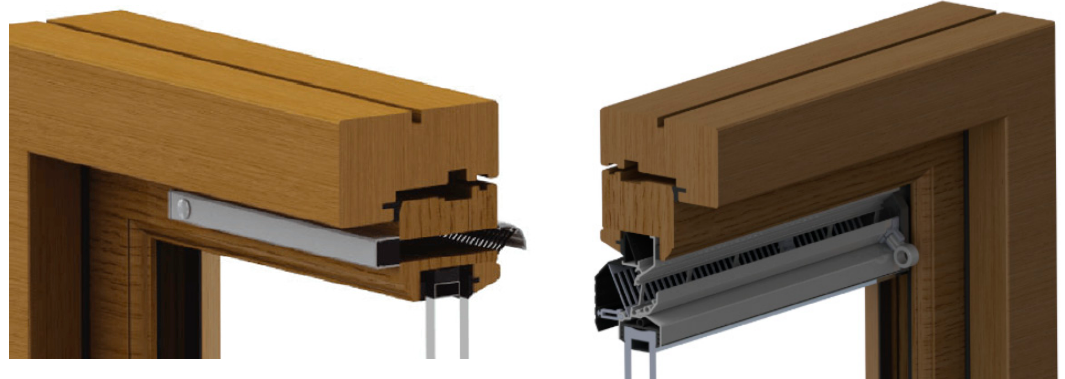
Figure 8. Surface-Mounted Trickle Vents ( left ); Glazed-In Trickle Vents ( right ) [50,51]. A list of some patented vents of both types available in the market is shown in Table 2.